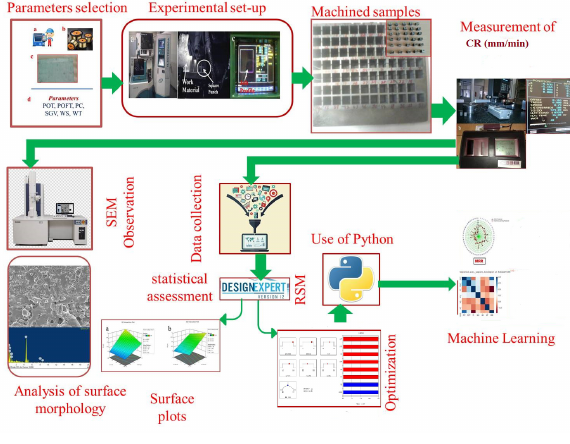
Figure 1: Schematic of the experimental setup with methodologies